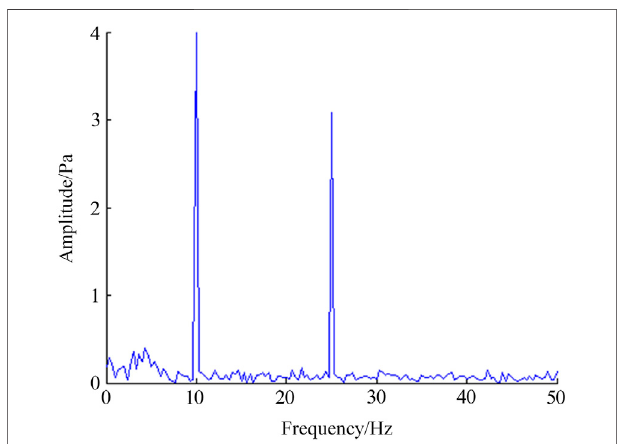
FIGURE 14 | Spectrum of the signal after denoising by improved